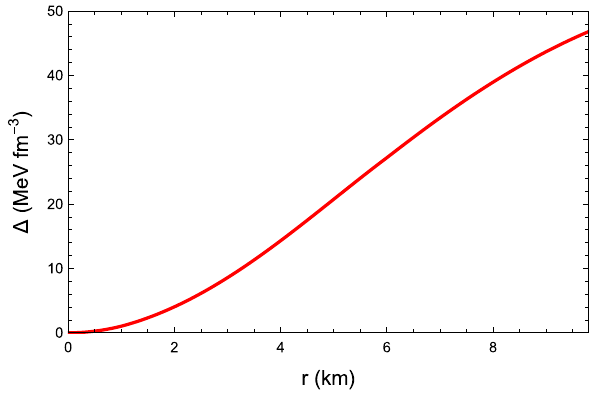
Fig. 4 Variation of anisotropy (cid:9) the gradient of energy density, radial pressure, and tangential pressure are respectively obtained as